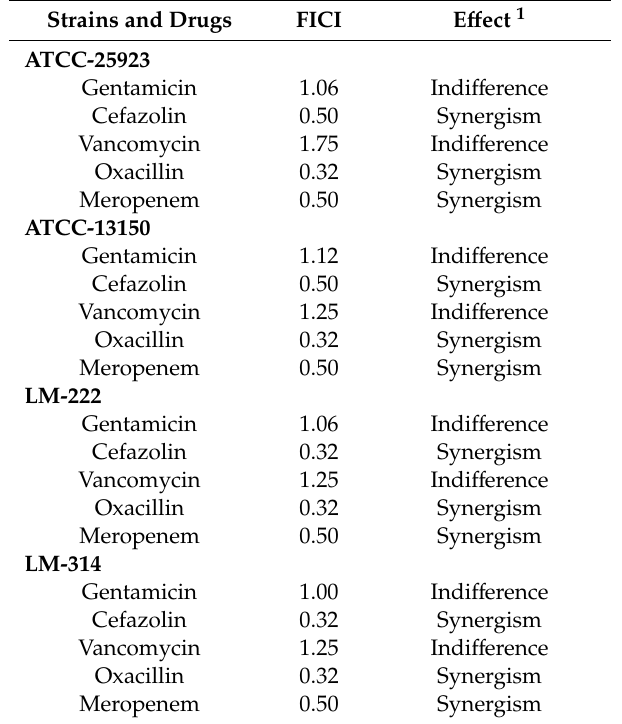
Table 3. Terpinen-4-ol in association with di ff erent antibacterial drugs against S.